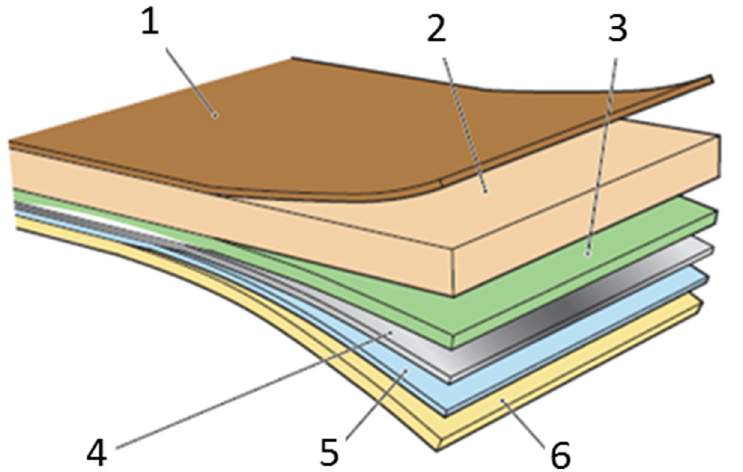
Figure 1. Typical composition and functionality of beverage packaging material: (1) external plastic layer, protects against outside moisture and enables sealing; (2) paperboard, gives stability and strength and enables printing; (3) lamination layer, enables adhesion between aluminum foil and paperboard; (4) aluminum foil, acts as oxygen, flavor and light barrier; (5) adhesion layer between the aluminum foil and the internal plastic layer; (6) internal plastic layer, seals in the liquid product and enables hermetical